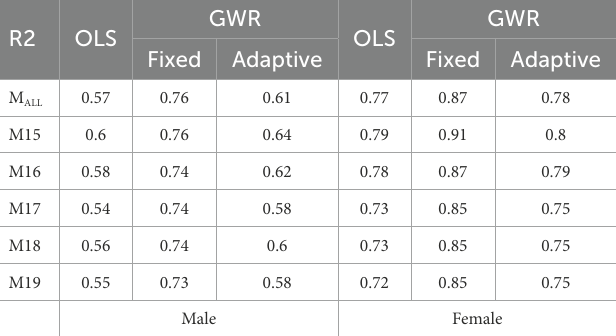
TABLE 2 Percent of variance explained (R 2 ) by regression